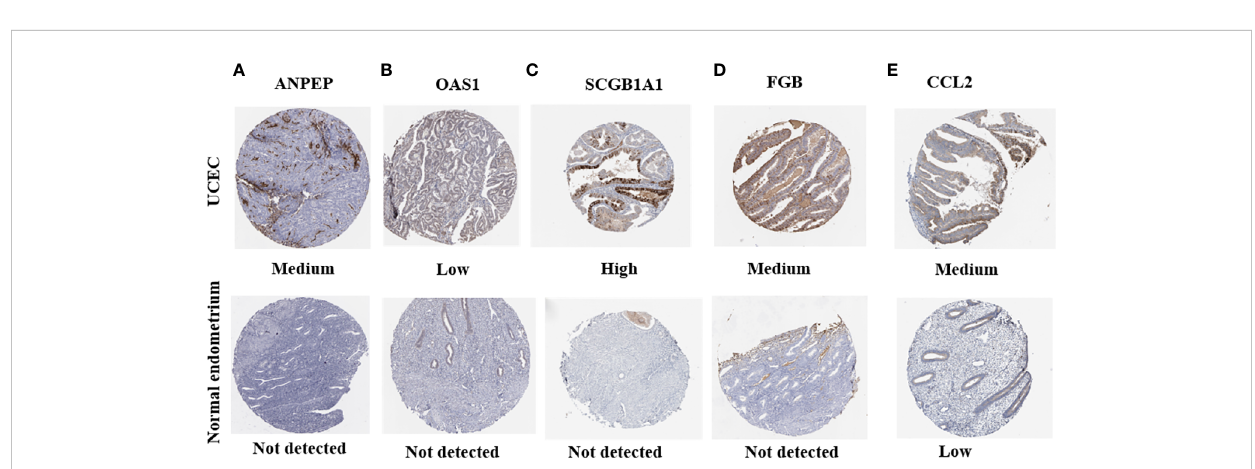
FIGURE 12 The protein expression of prognostic genes in UCEC tissues and normal endometrial tissues. (A) ANPEP , (B) OAS1 , (C) SCGB1A1 , (D) FGB , and (E) CCL2 .